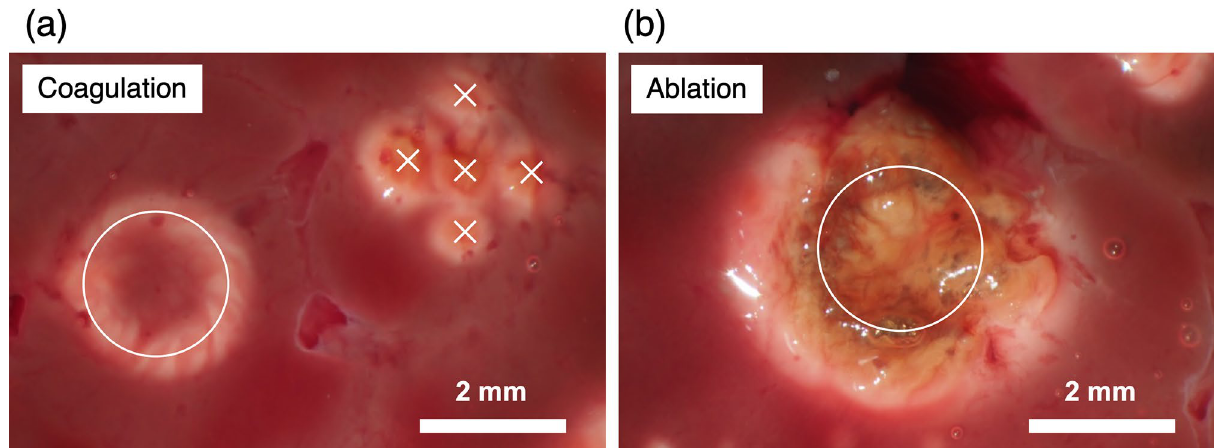
Figure 7. Photographs of chicken liver after ( a ) tissue coagulation and ( b ) ablation. The white circles and crosses indicate the laser steering trajectories and irradiated points,